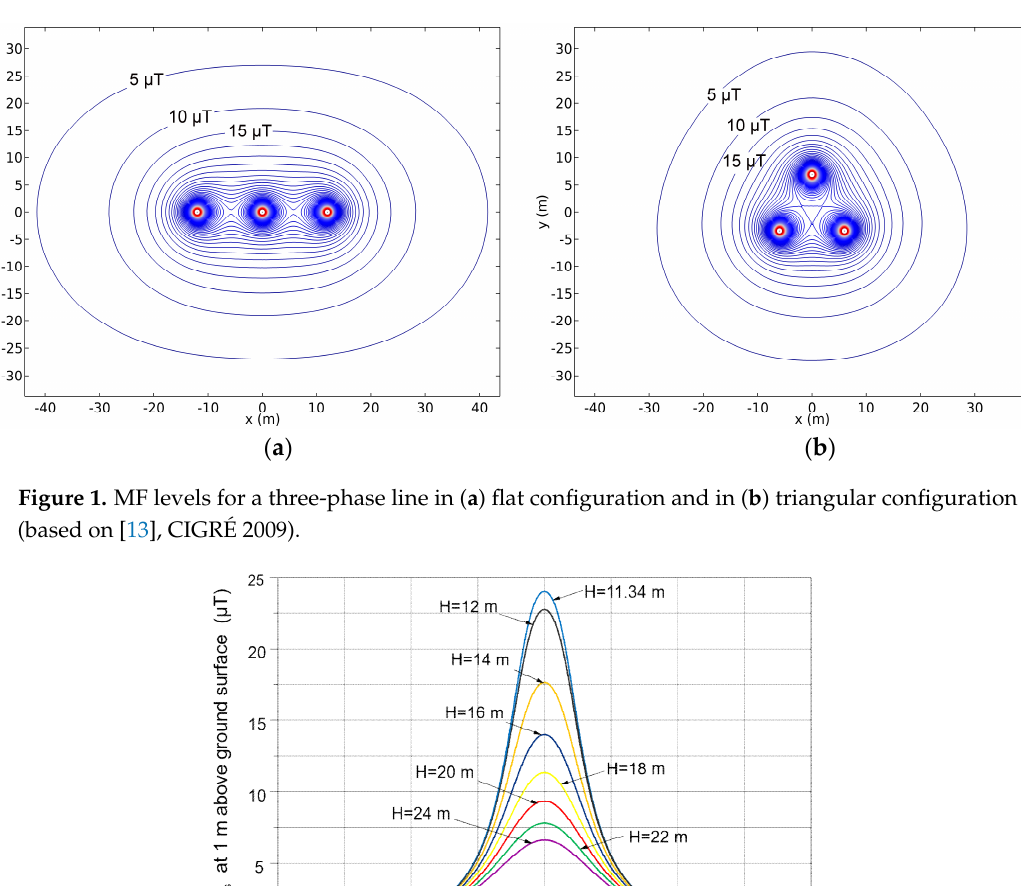
Figure 2. MF at 1 m above ground surface for various heights (H) for a three-phase line (based on [13], CIGRÉ 2009).